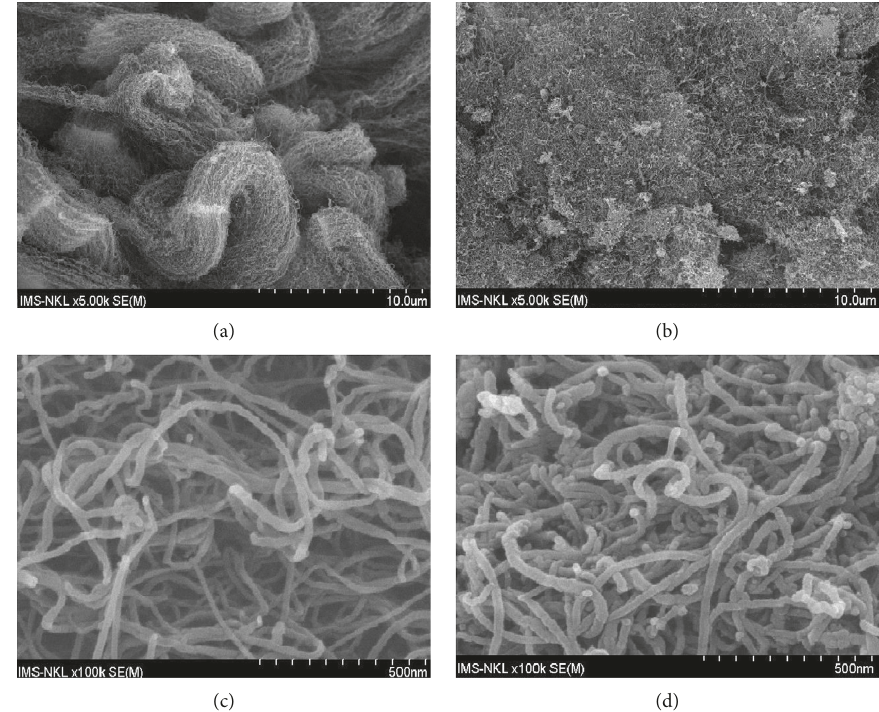
Figure 2: SEM images at low ( × 5,000) and high ( × 100,000) magnifications of CNTs: before (left) and after (right) acidic modification.